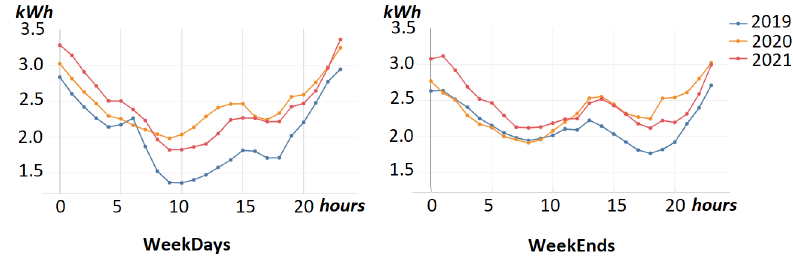
Figure 13. Mean hourly consumption profile for weekdays/weekends for April across 3 years. Comparison between